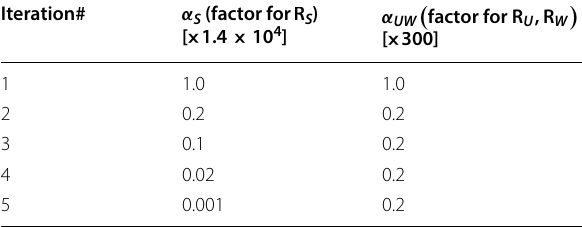
Table 2 Weight factors for observation error covariance matrices in generation of the IGRF13-SV candidate model